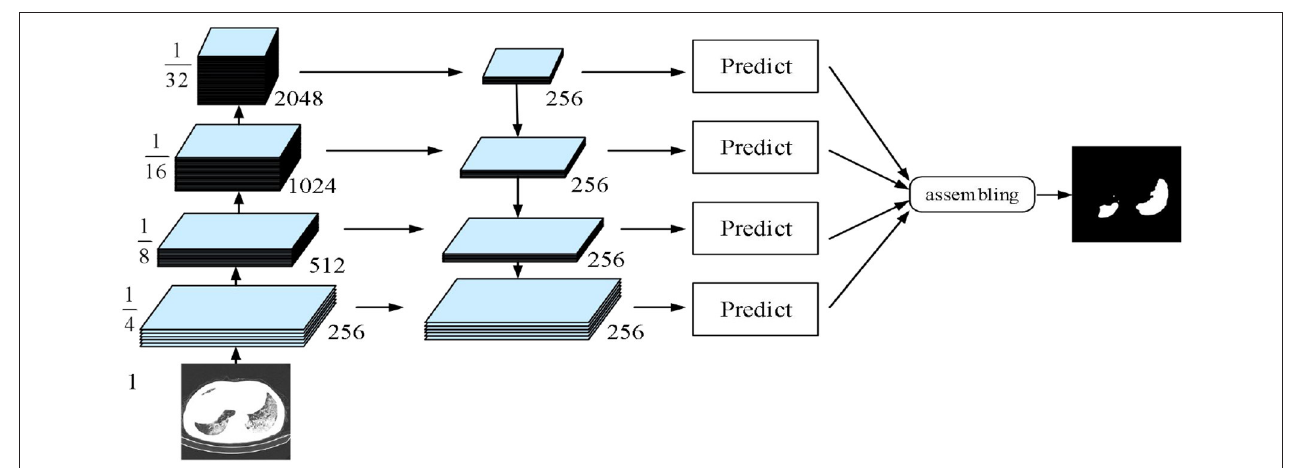
FIGURE 7 | Feature pyramid network (FPN)